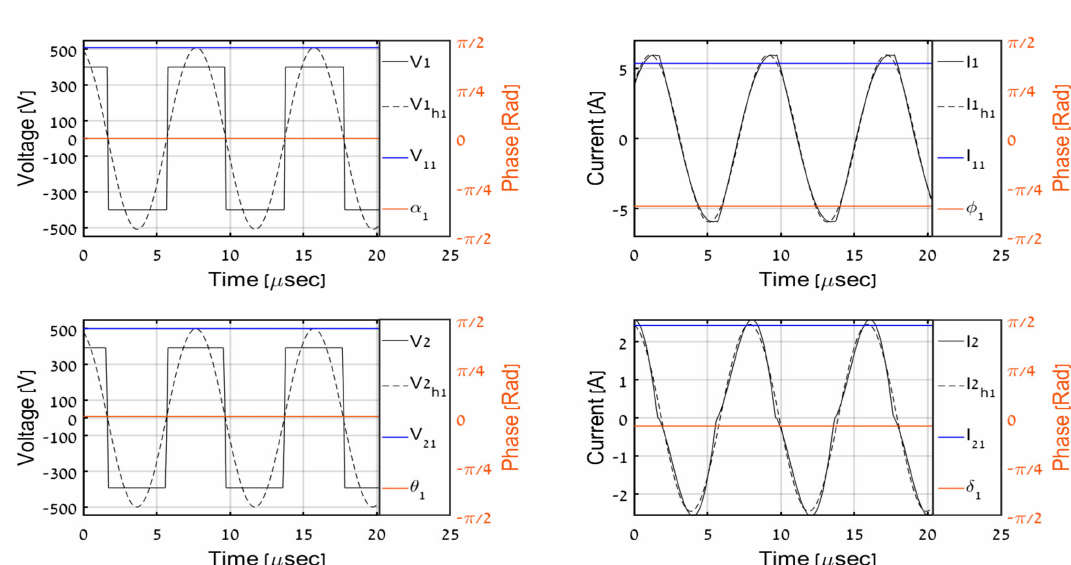
Figure 10. Simulation results, P O = 600